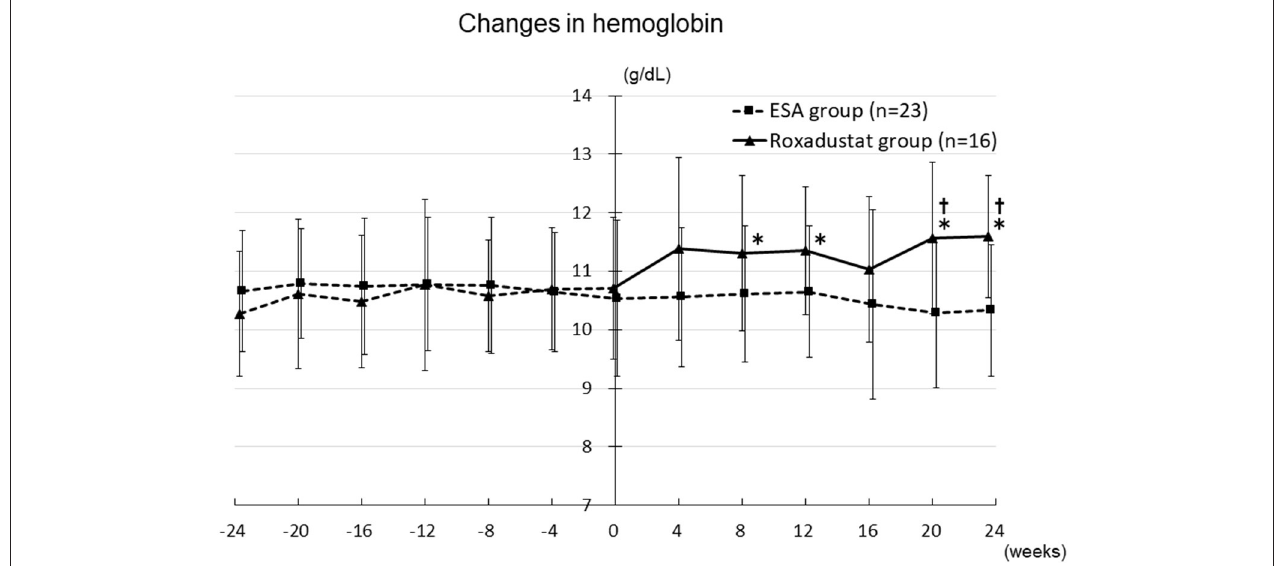
FIGURE 6 | Changes in the hemoglobin concentration in the Roxadustat and ESA groups. ESA, erythropoiesis-stimulating agent; * p < 0.05 vs. − 24 weeks; † p < 0.05 vs. the ESA group.